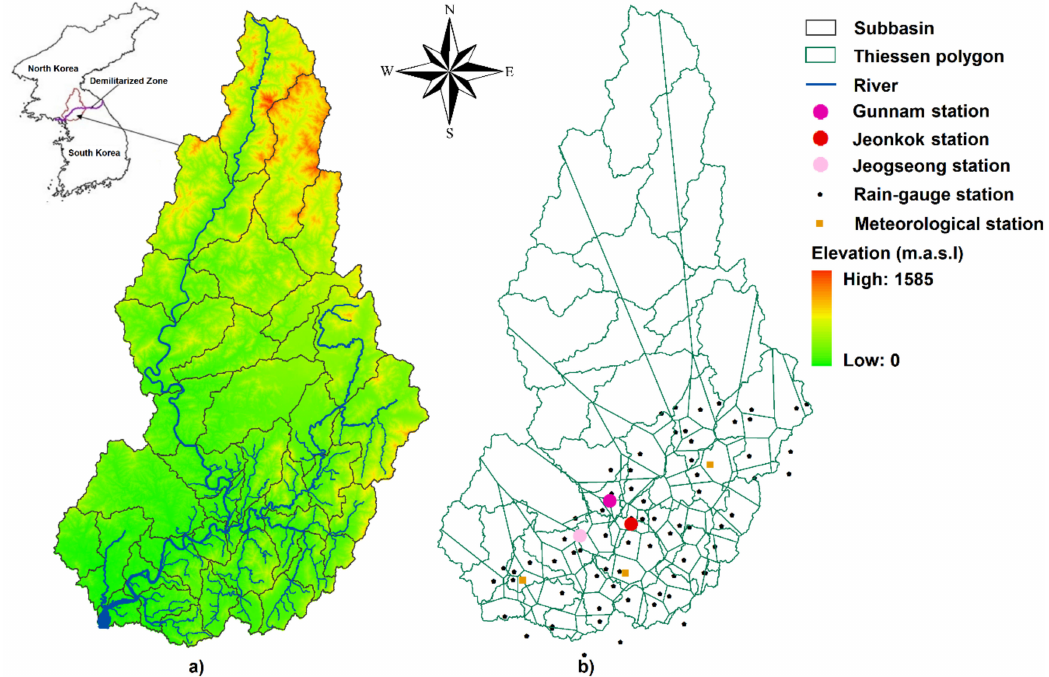
Figure 1. The Imjin river basin, Korean peninsula: ( a ) Subbasins, river network, and elevation (Digital Elevation Model, DEM); ( b ) Location of 68 rain-gauge stations, 3 meteorological stations, 3 flow stations, and Thiessen